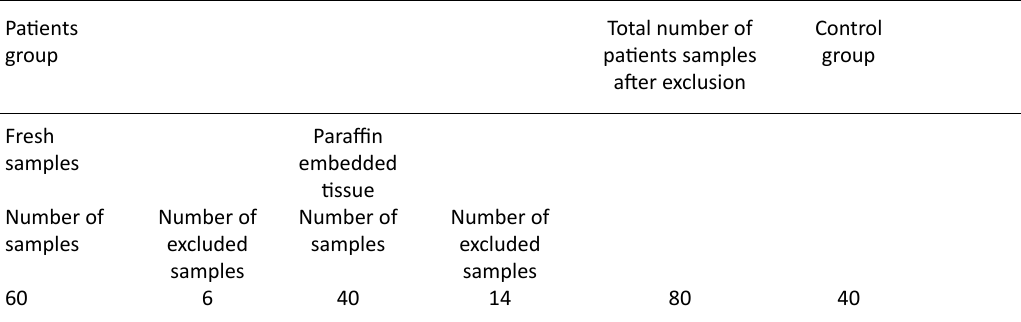
Table 3. Classification of samples included in this study